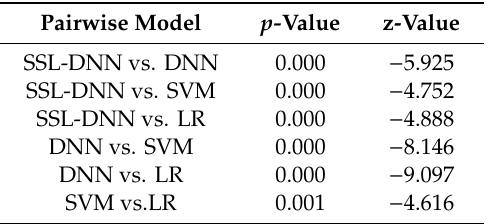
Table 5. Models pairwise comparison using the Wilcoxon signed-rank